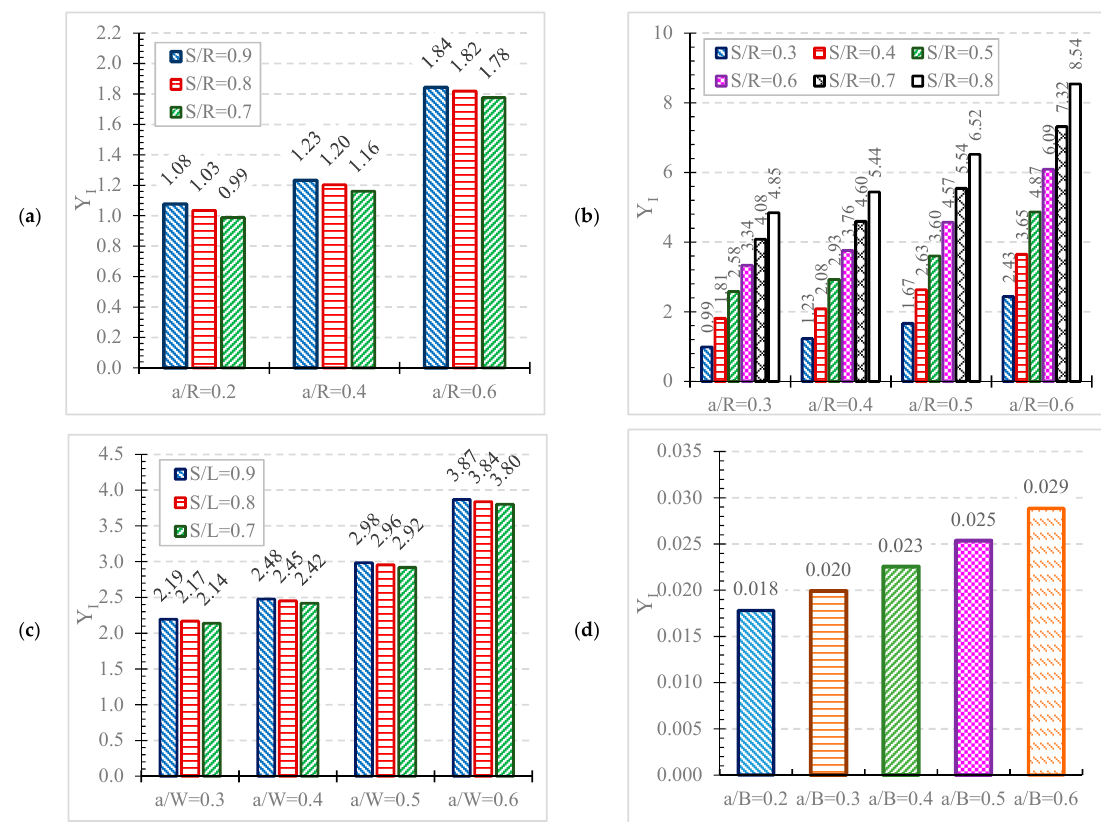
Figure 4. Variations of the mode I fracture geometry ( Y I ) for different geometry and loading conditions in the analyzed test samples using ABAQUS code: ( a ) ENDB, ( b ) SCB, ( c ) SENB and ( d ) ENDC.